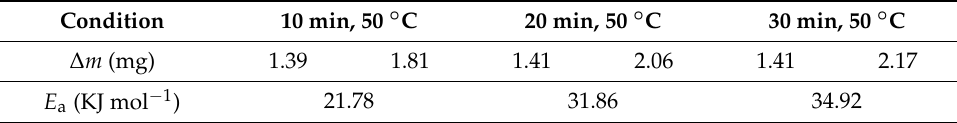
Table 1. Apparent activation energy at the three growth stages of the LDH